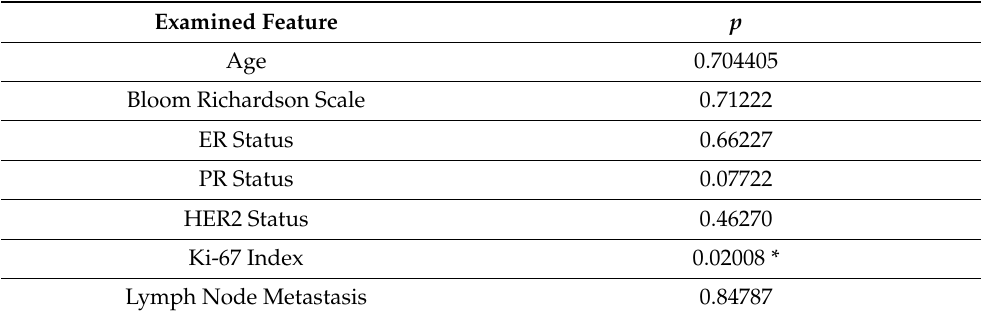
Table 2. Prevalence of mutations depending on clinical